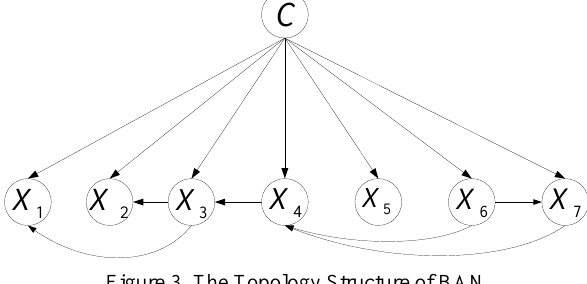
Figure 3. The Topology Structure of BAN